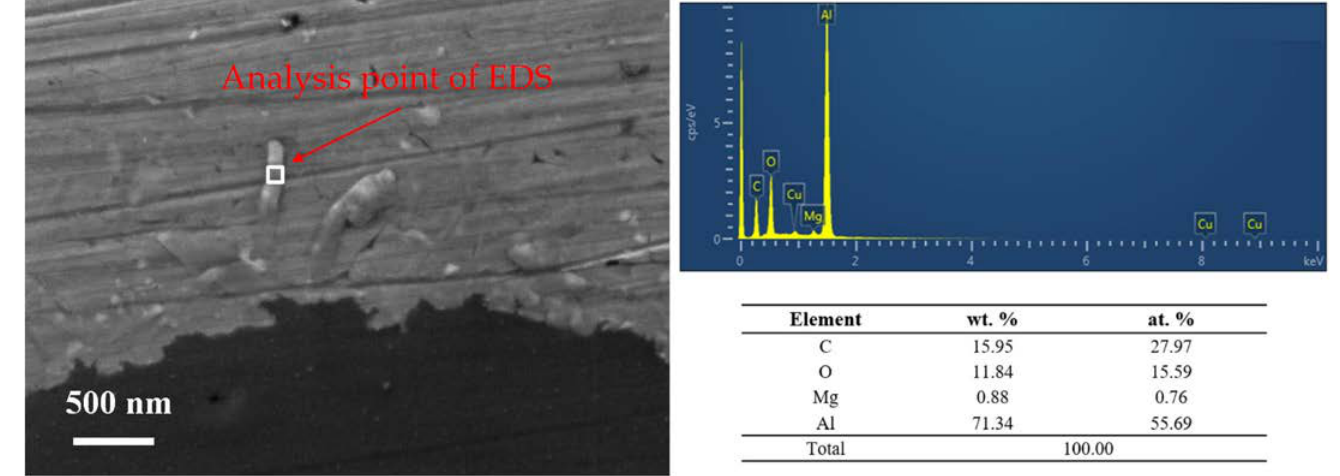
Figure 10. Morphologies fracture surface of SCFs/2024 Al (polished smooth), thermal exposure time 0 h; SEM morphology of the stack-like interface product in SCFs/2024 Al composite and its corresponding elements distribution obtained by EDS analysis.